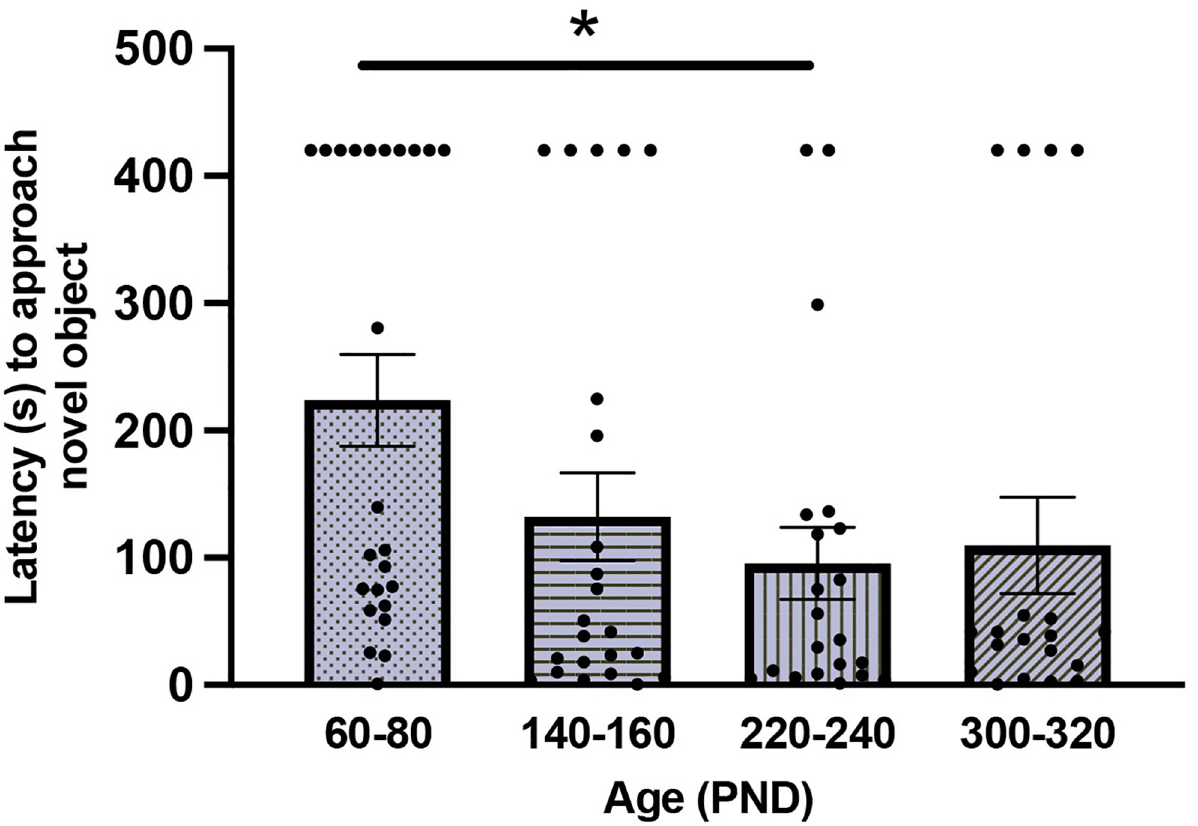
Fig 1. Mean ± SEM time (seconds, s) to approach a novel object for each age group. Voles between PND60-80 exhibited a greater latency to approach the object compared to voles aged PND220-240. Dots represent individual data points. � indicate statistical significance.